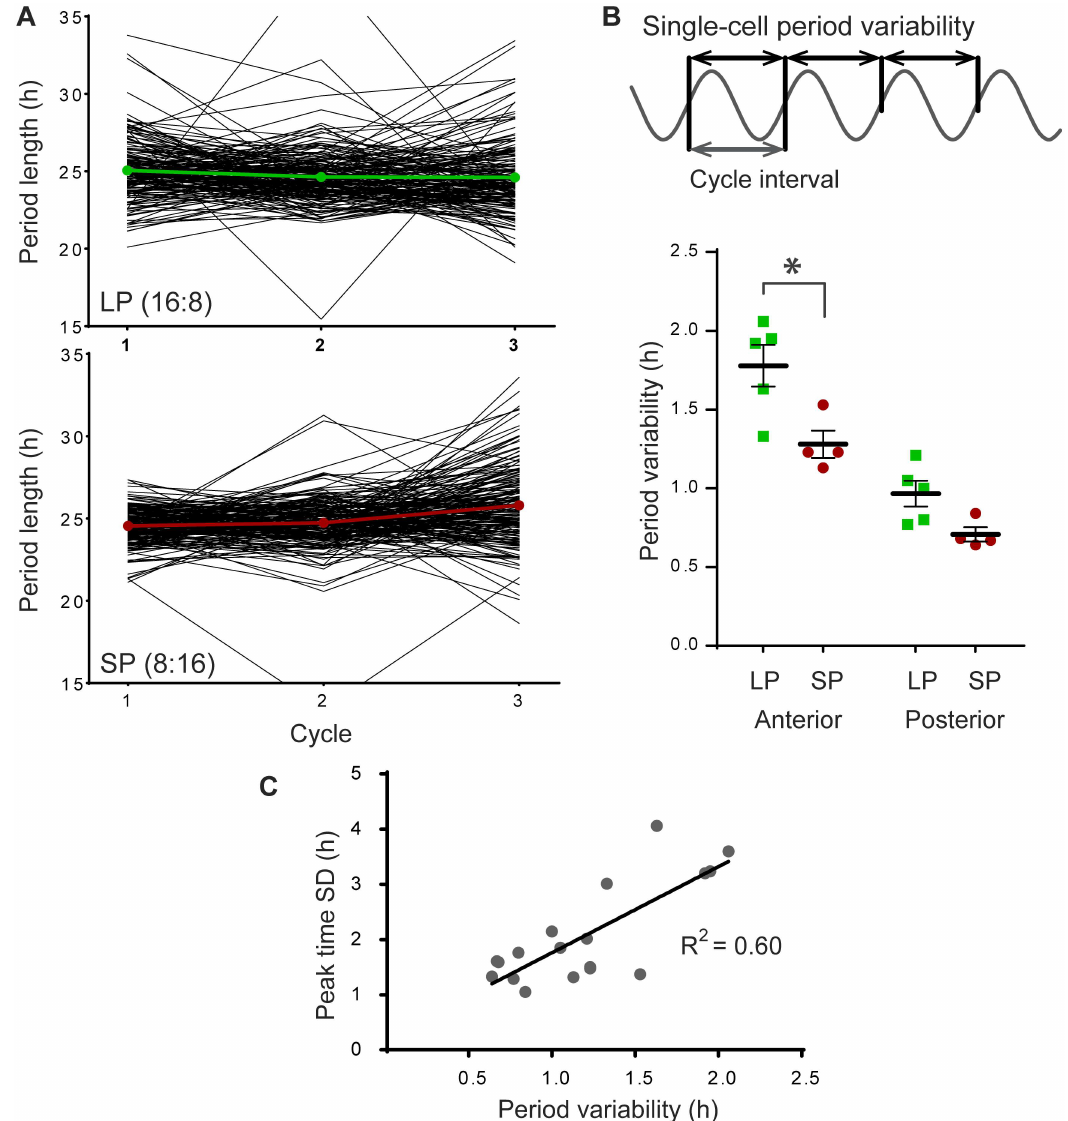
Fig 3. Single-cell period variability (SD) increases after exposure to long photoperiod. (A) Representative examples of the variabilityin single-cellcycle-to-cycle interval from anterior SCN slices in long (LP, n = 177; top panel) and in short photoperiod(SP, n = 183; bottom panel). Black traces show the cycle-to-cycle interval of individualcells for the first three cycles in vitro ; colored traces show the averageperiodper cycle for the presented slice. (B) Cycle intervalis definedas the cycle-to-cycle time difference betweenthe half-maximum of the rising edge of the PER2::LUCexpressionrhythm. The variabilityin periodis definedas the standarddeviation(SD) of the cycle interval of individual cells, calculatedfor the first three cycles in vitro (top panel).Single-cellperiod variability was averagedper slice and is shown for the anterior SCN, in LP (green squares) and SP (red circles; bottom panel). Black bars indicatemean ± SEM. (C) Linear regression of the relationshipbetweensingle-cell period variability and peak time SD for all recordings ( n = 18, p < 0.001).